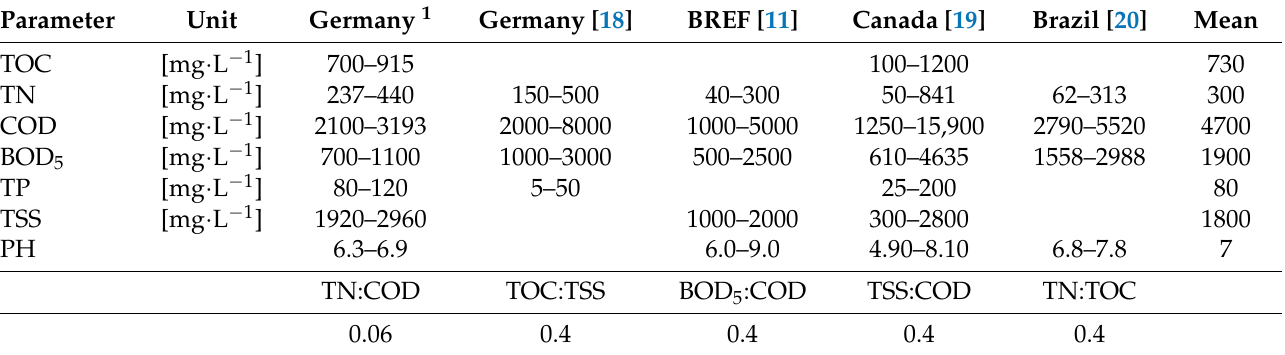
Table 1. Slaughterhouse wastewater characteristics.